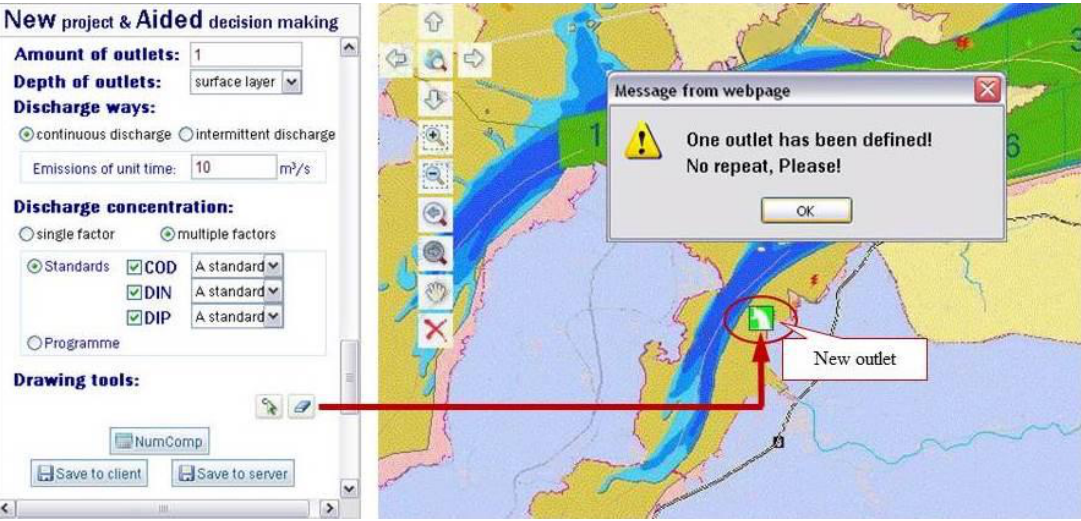
Figure 10. The new land-based outlet defined on part of the webpage.